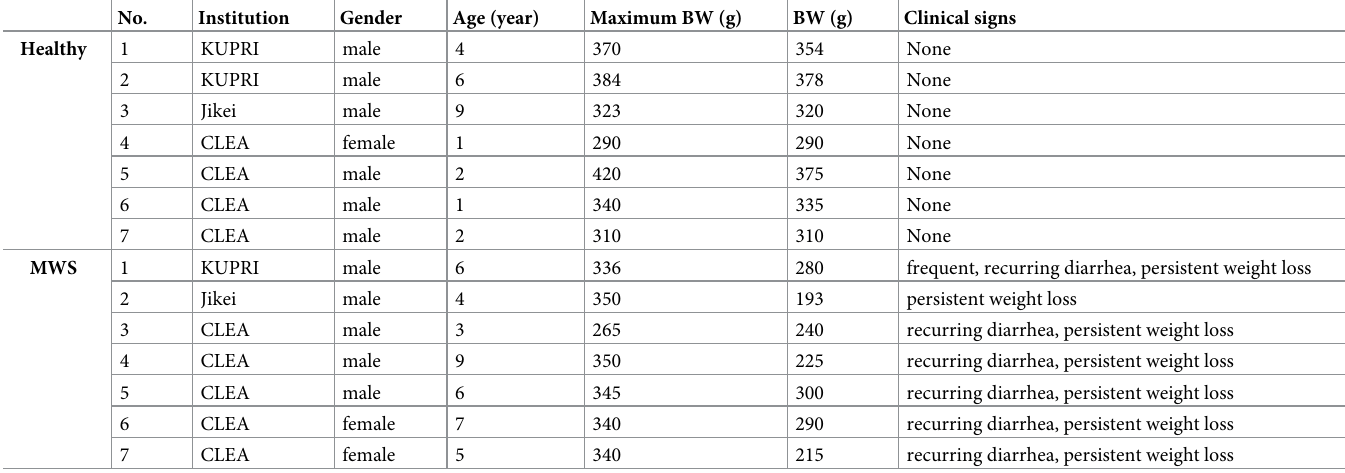
Table 2. Body weight and clinical signs in individual